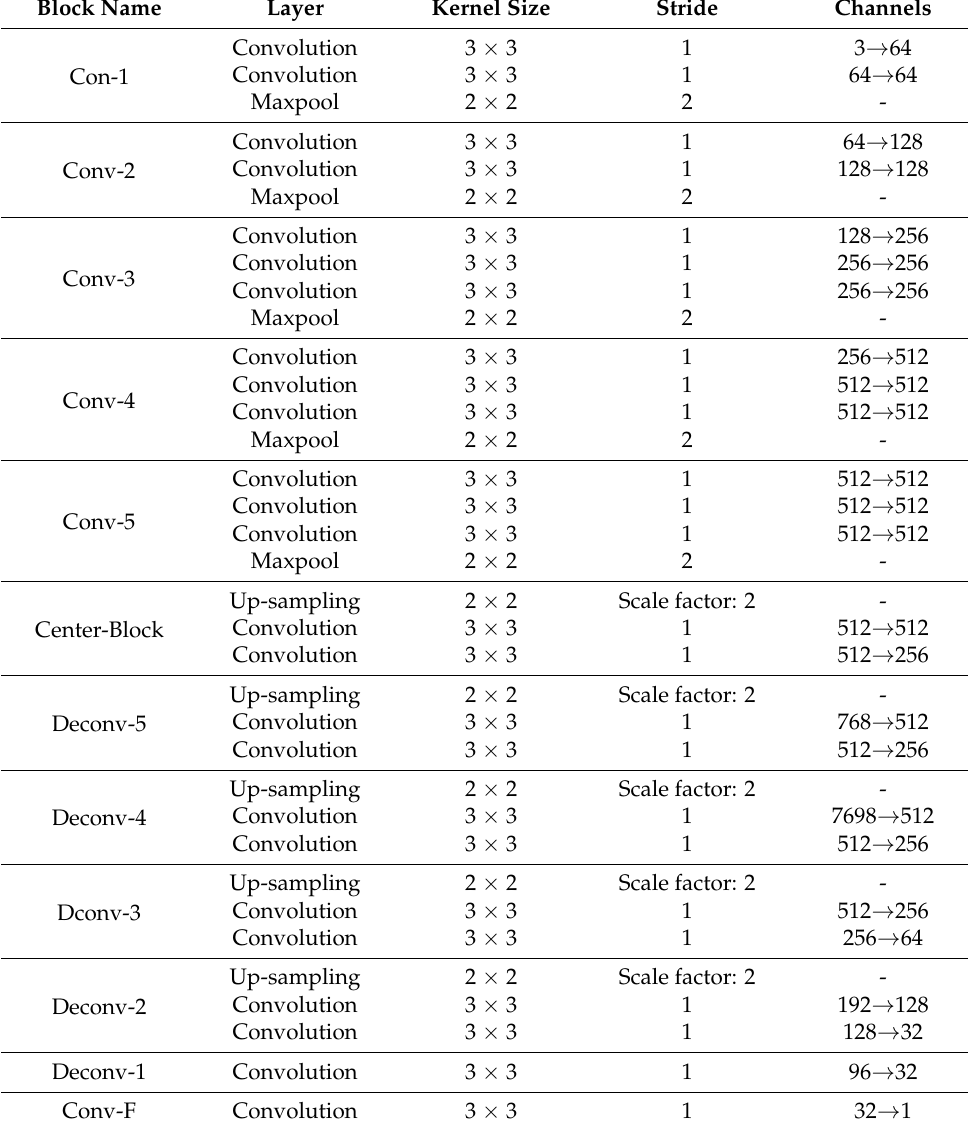
Table 1. Complete composition of the employed U-Net-based model.